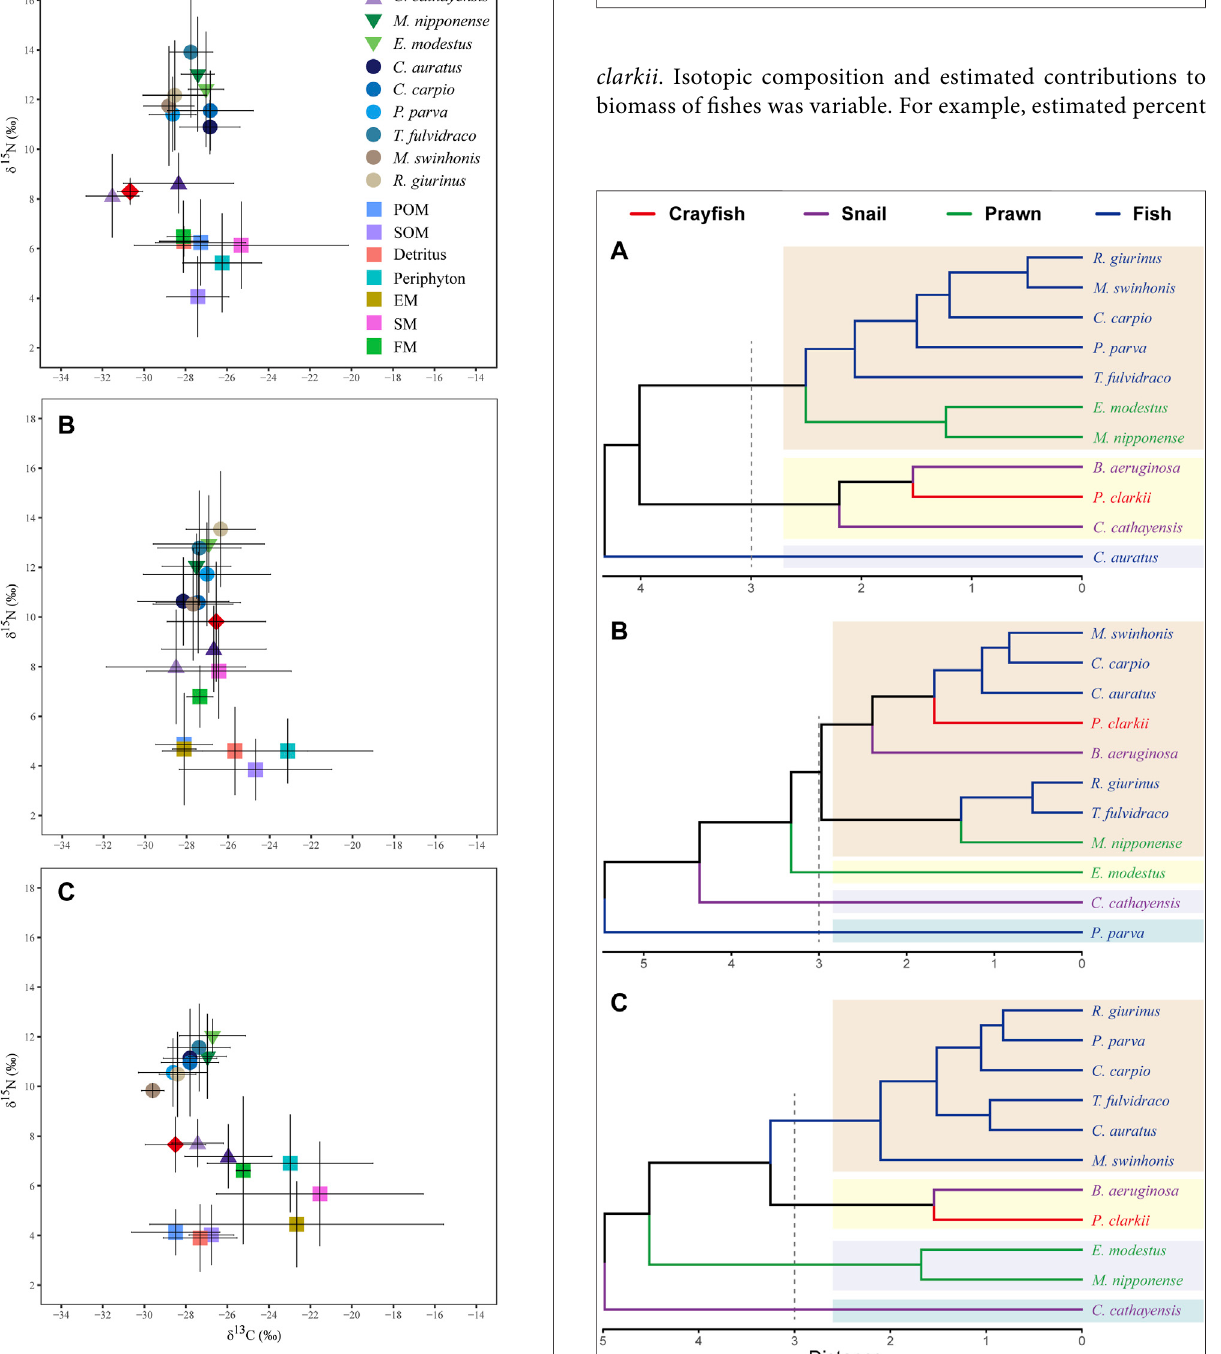
FIGURE 2 | suspended particular organic matter, SOM = organic matter in surface sediments, EM = emergent macrophytes, SM = submerged macrophytes, FM = fl oating